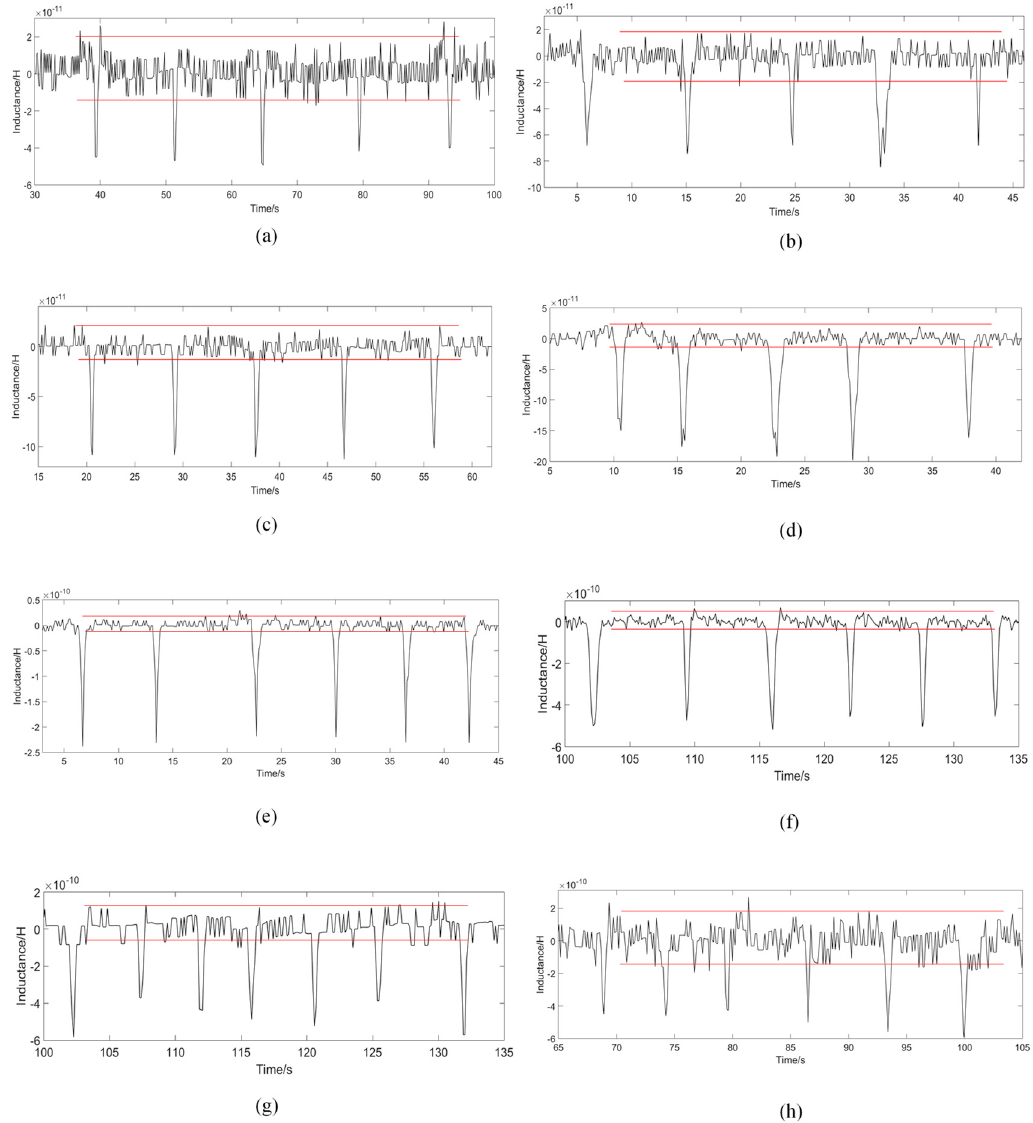
Figure 7. The detection signal value of different solenoid coils on 90 μ m copper particles, ( a – h ) is 100~450 turns.